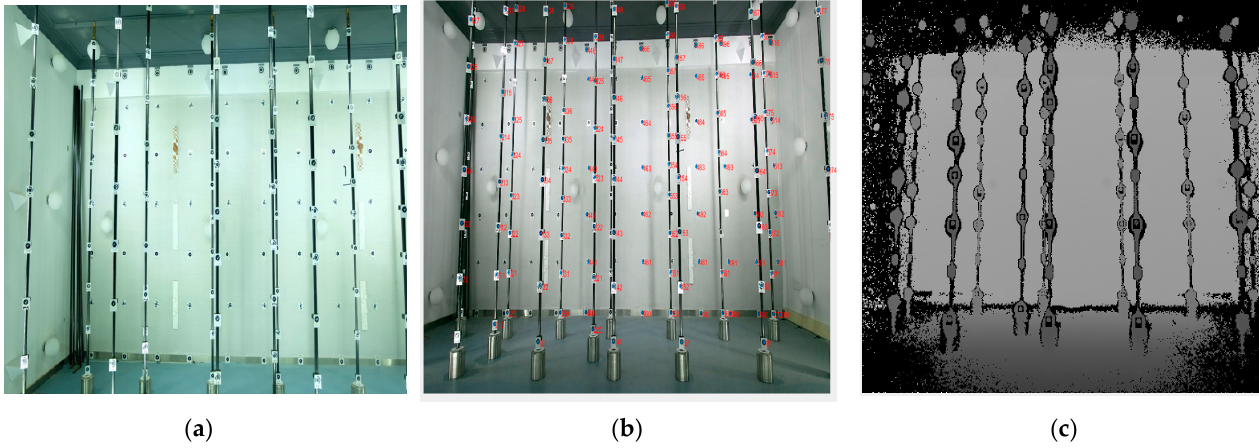
Figure 2. Images collected from the 3D calibration field. ( a ) 3D calibration field; ( b ) RGB image within known calibration points; and ( c ) depth image.